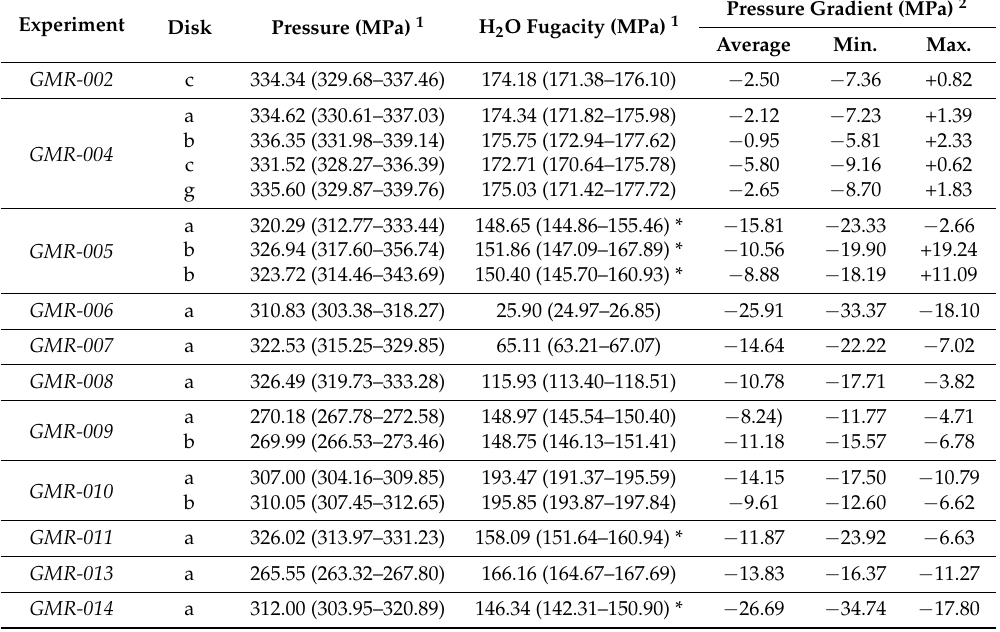
Table 4. Average conditions in fluid inclusions during re-equilibration experiments, calculated from measured homogenization temperatures after synthesis (Table 2).